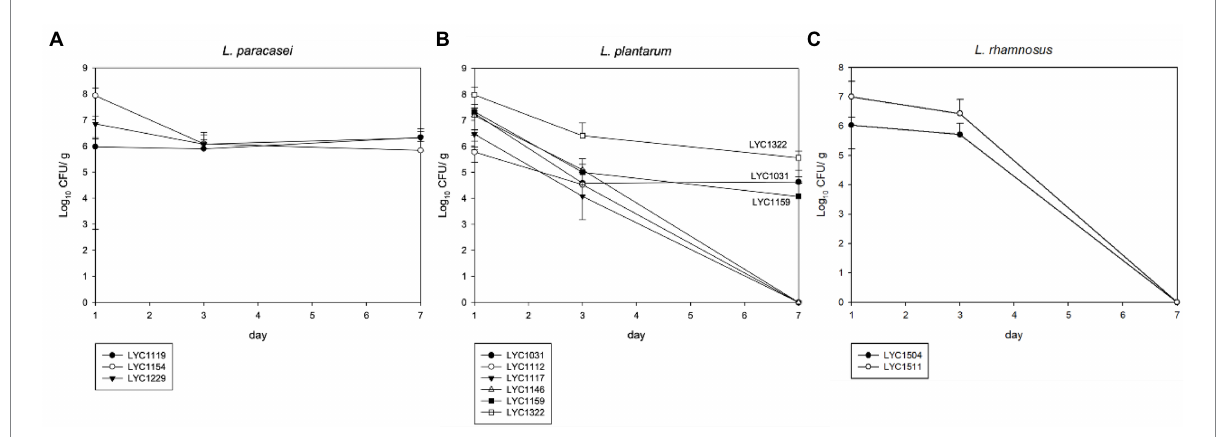
FIGURE 3 The Lactobacillus number in feces after each oral treatment. (A) L. paracasei , (B) L. plantarum , and (C) L. rhamnosus. (The Lactobacillus strains in stool are shown in CFUs/g as the mean ±